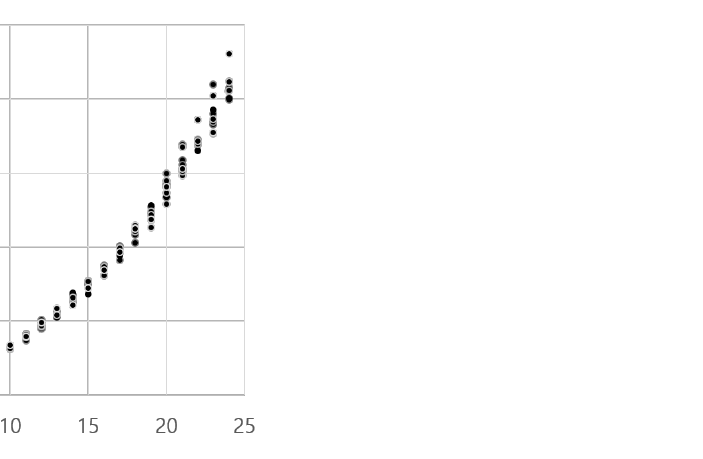
Figure 21. Selection of images is randomly chosen among the 25 images. As the number of images is selected, the computational complexity increases accordingly. Computational complexity is repre- sented using time (seconds), and the horizontal axis represents the number of selected images ( n s ). Table 1. Computation time (s) with the number of images used for synthesis.